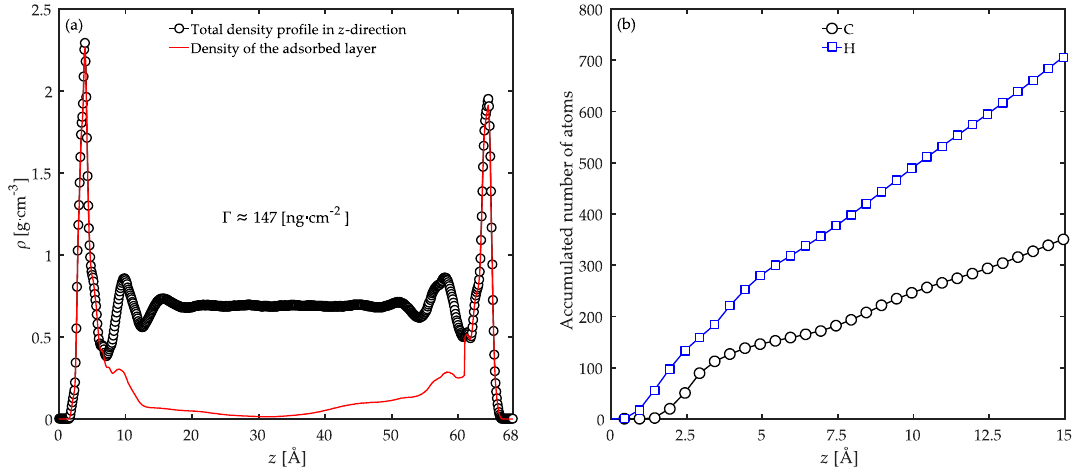
Figure 4. ( a ) Local contributions to the total mass density profile ( open circles ) from segments of the first polymer layer adjacent to the substrates ( red continuous line ); ( b ) The accumulated number of hydrogen and carbon atoms across the film thickness calculated from the number density profiles of the corresponding atoms. The results are calculated for the confined PP/Fe 2 O 3 system at 458 K and 1 atm.